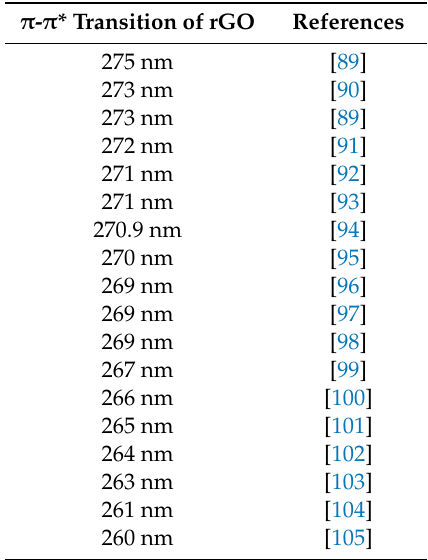
Table 1. Peak (C = C bonds) of UV-vis absorbance of rGO from various reduction approaches. π - π * Transition of rGO